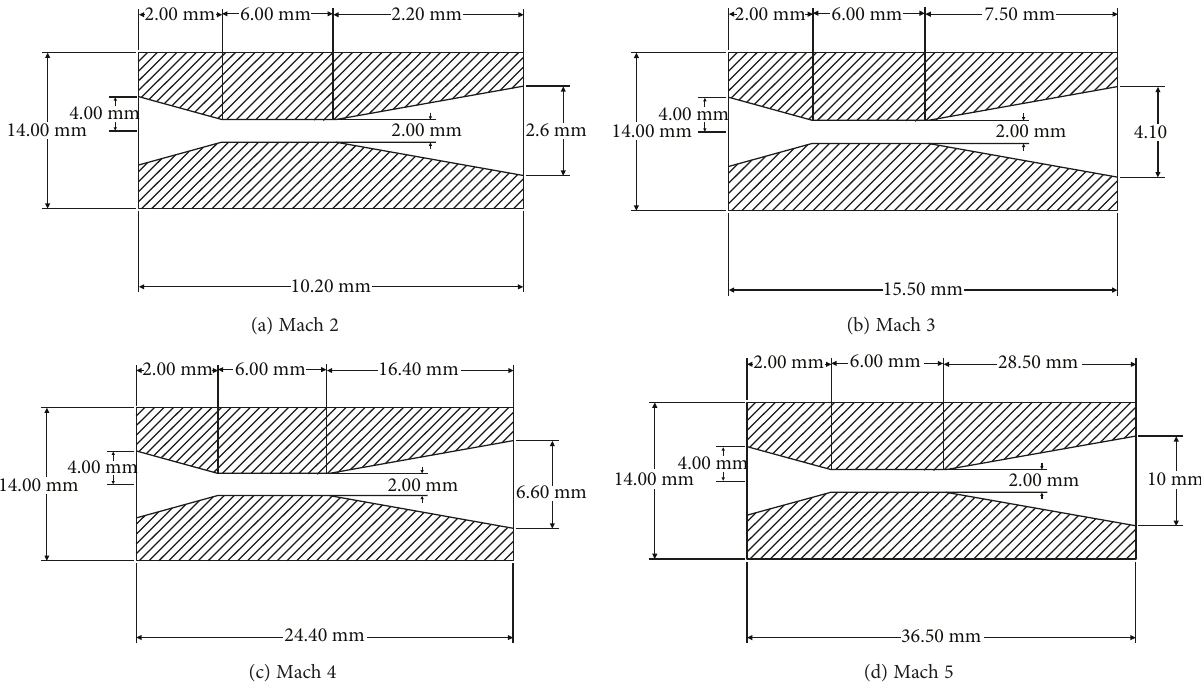
Figure 2: Preliminary Laval nozzle